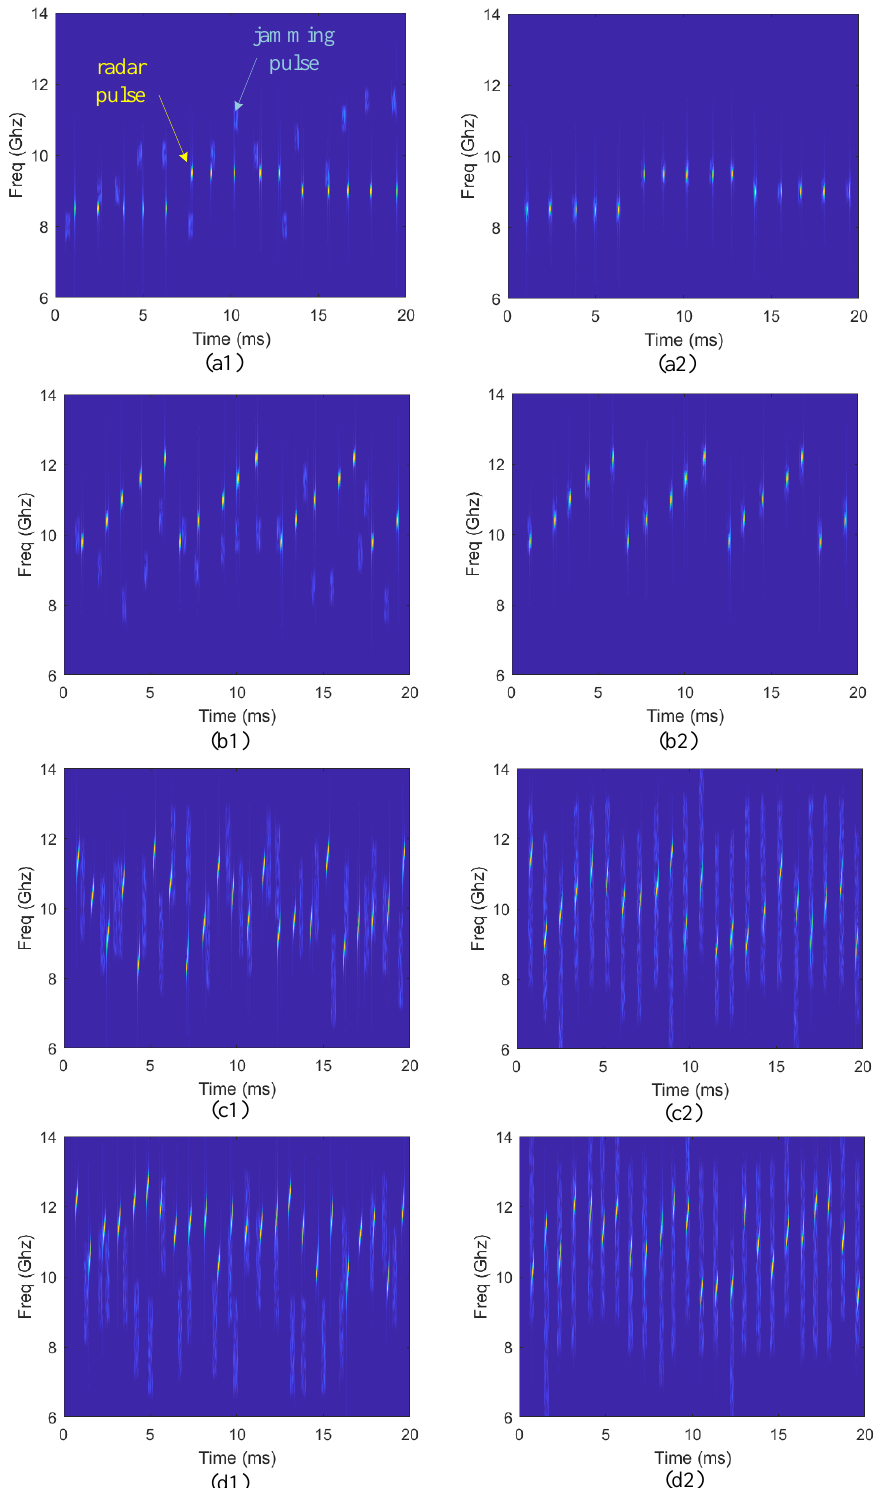
Figure 5. Time-frequency information at the initial and convergent stage: for signals in each image, the brighter strips are radar pulses, the darker strips are jamming pulses. ( a1 , b1 , c1 , d1 ) show time- frequency information of radar and jamming pulses at initial stage when the radar is at mode M r M r , M r , and M r , respectively. ( a2 , b2 , c2 , d2 ) show the corresponding time-frequency information at 5 7 4 convergent stage for the same four radar